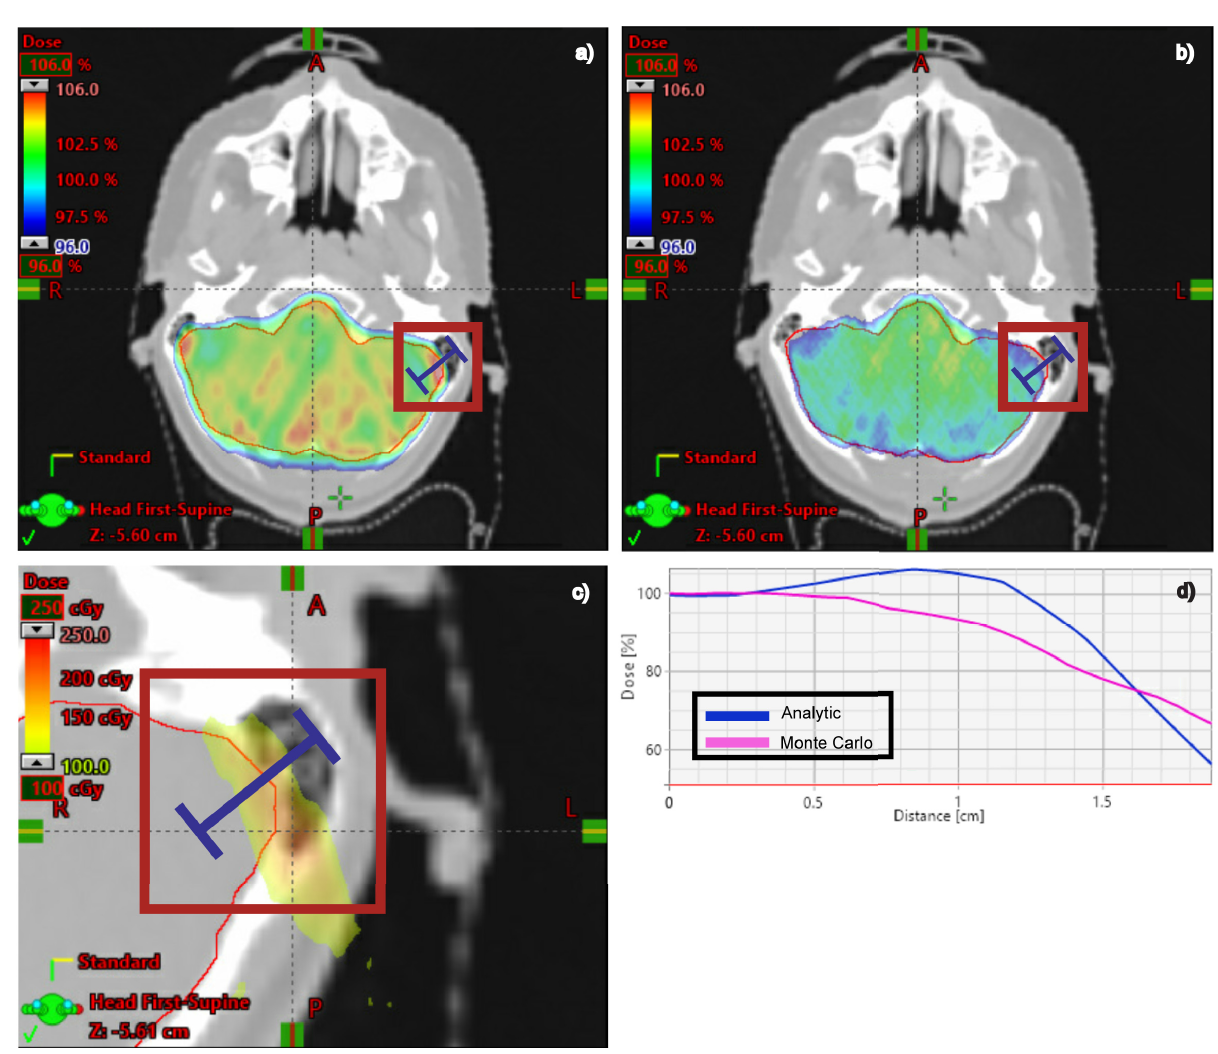
Fig 6. Analytic vs. Monte Carlo dose calculation comparison. Dose distributions calculated using the analytic TPS algorithm (a) are compared to those calculated with our GPU-accelerated, Monte Carlo dose second check system (b). Part (c) shows the absolute dose difference between (a) and (b) in a zoomed-in region for this 1440-cGy prescription dose. The scale bar of 100 cGy to 250 cGy corresponds to the percent range of 6.9% to 17.4%. A dose profile (d) through this region clearly shows an area of greater than 10% lower radiation dose in the target when comparing the Monte Carlo curve (pink) to the analytic TPS